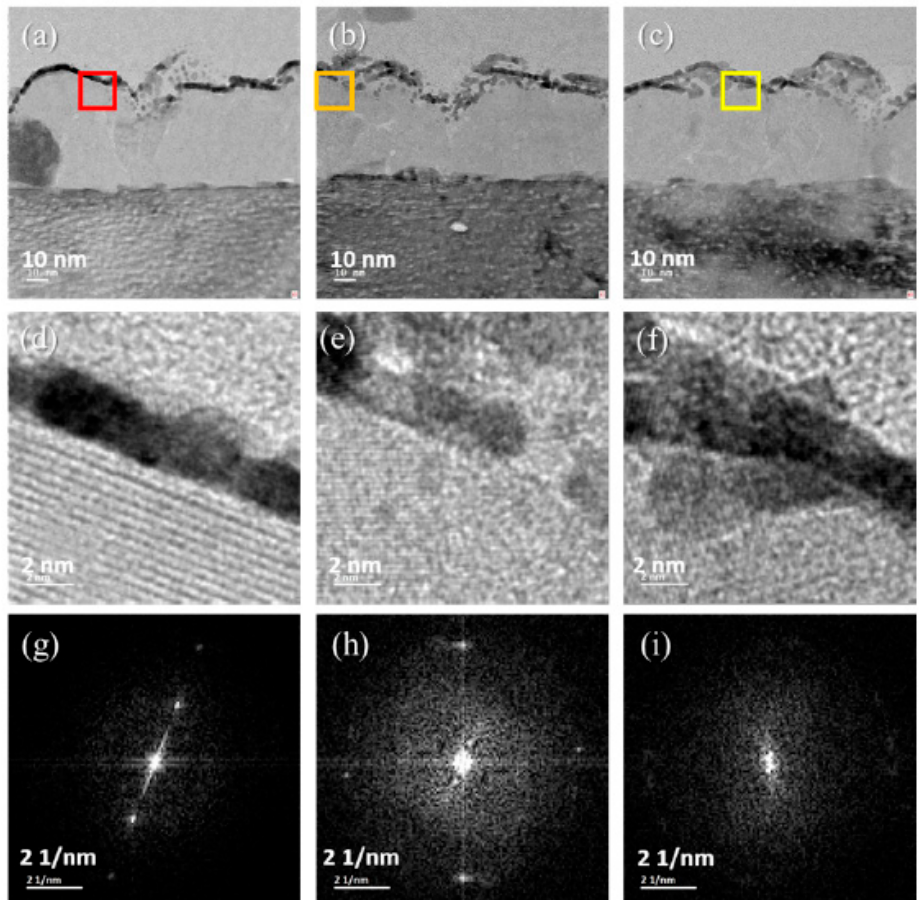
Figure 7. Panels ( a – c ) represent the TEM images of Sample 2 in sampling locations A, B, and C, respectively; ( d – f ) represent the HRTEM images of the red, orange, and yellow boxes in ( a – c ), respectively; and ( g – i ) represent the SAED diagram in ( d – f ), respectively.